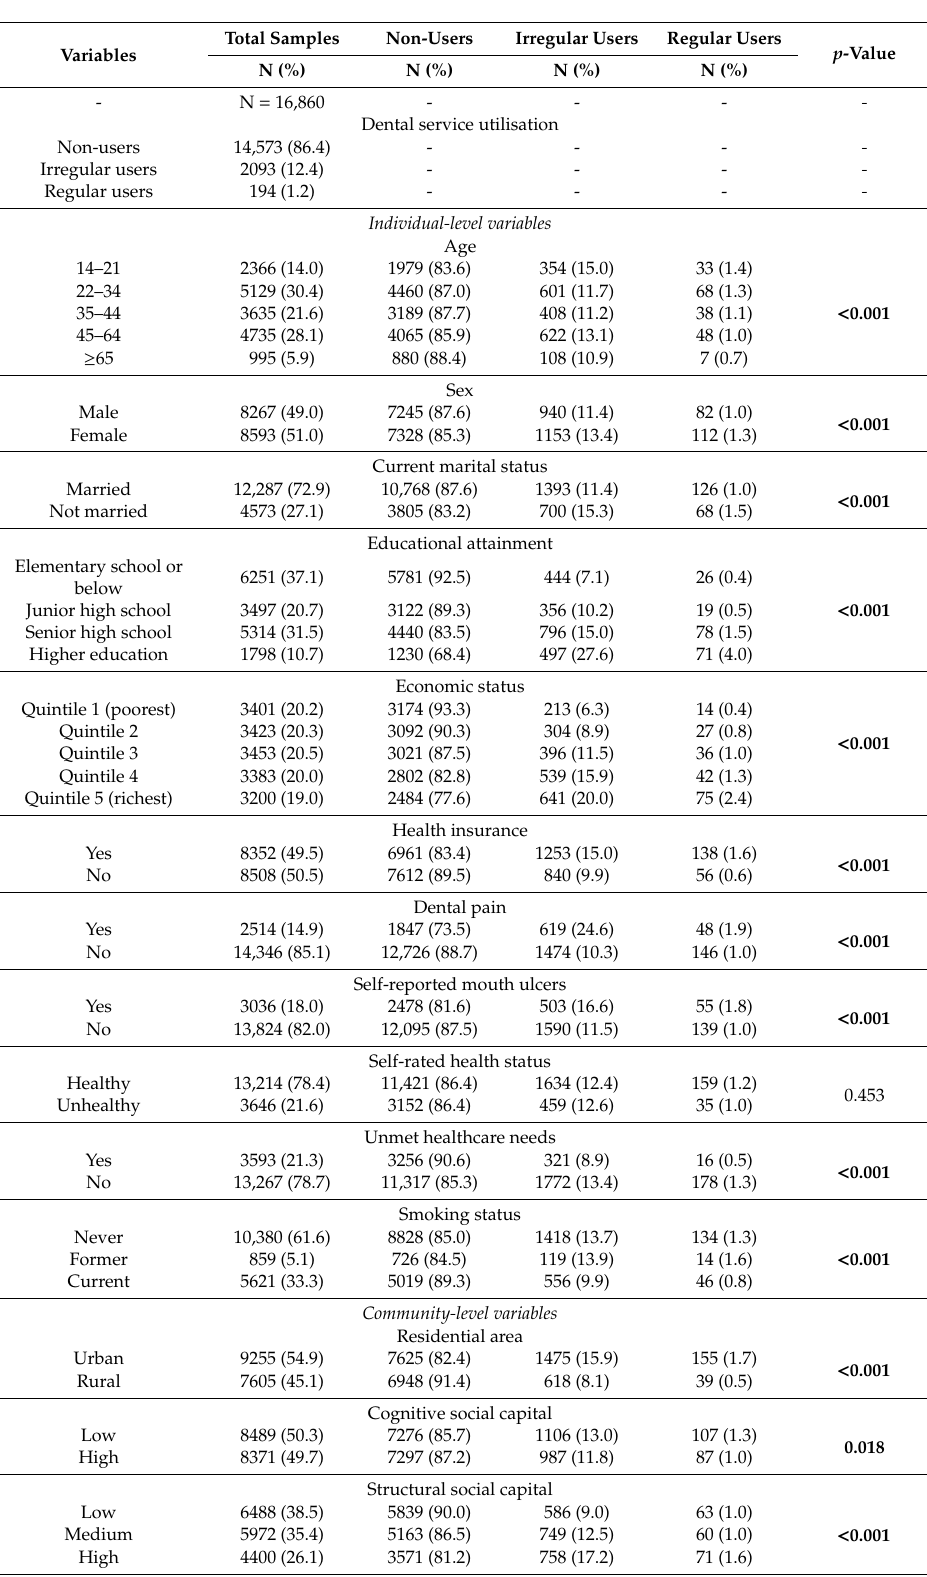
Table 1. Distribution of individual and community characteristics of the study population by the status of dental service